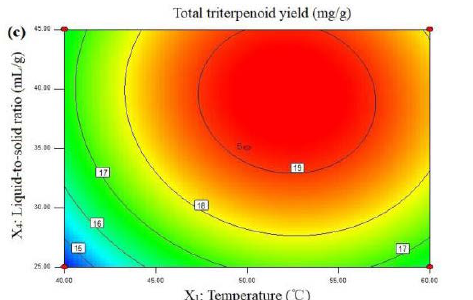
Figure 1. Contour plot ( a , c ) and three-dimensional (3D) surface plot ( b , d ) showing the interaction e ff ects of the process variables on the total triterpenoid yield. ( a , b ): the interaction between temperature ( X 1 ) and time ( X 3 ) on total triterpenoid yield ( Y ); ( c , d ): the interaction between temperature ( X 1 ) and liquid-to-solid ratio ( X 4 ) on total triterpenoid yield ( Y ).